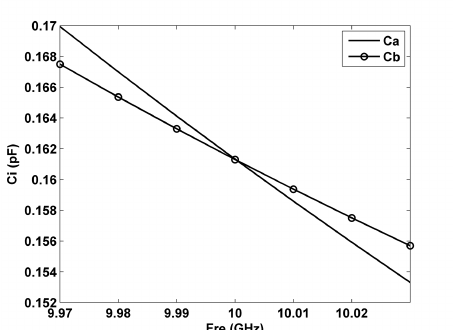
Figure 8. The equivalent Capacities of the directional